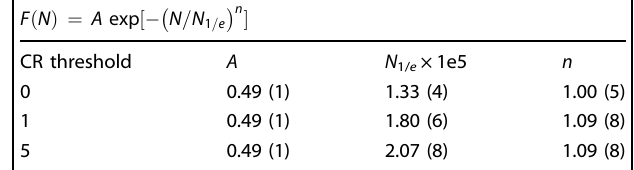
Table 2. Fit parameters for Fig. 2c, upper